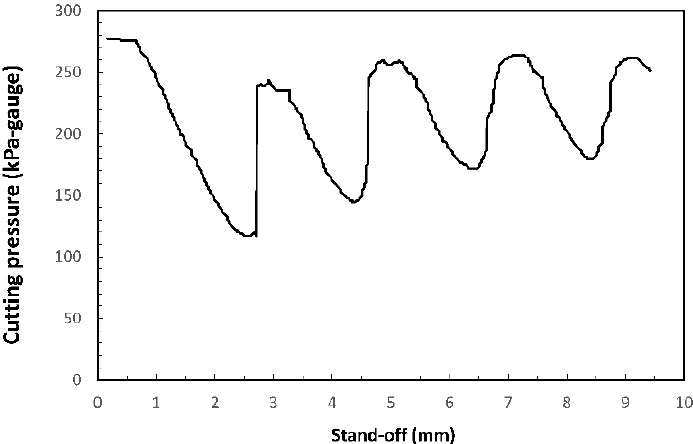
Figure 5. Variation of the pressure along the jet (air, conical nozzle, nozzle diameter d = 1.5 mm, gauge pressure p = 280 kPa) when the workpiece is moved away with regard to the laser beam. Reprinted with permission from [27]; Copyright 1984 ICALEO.